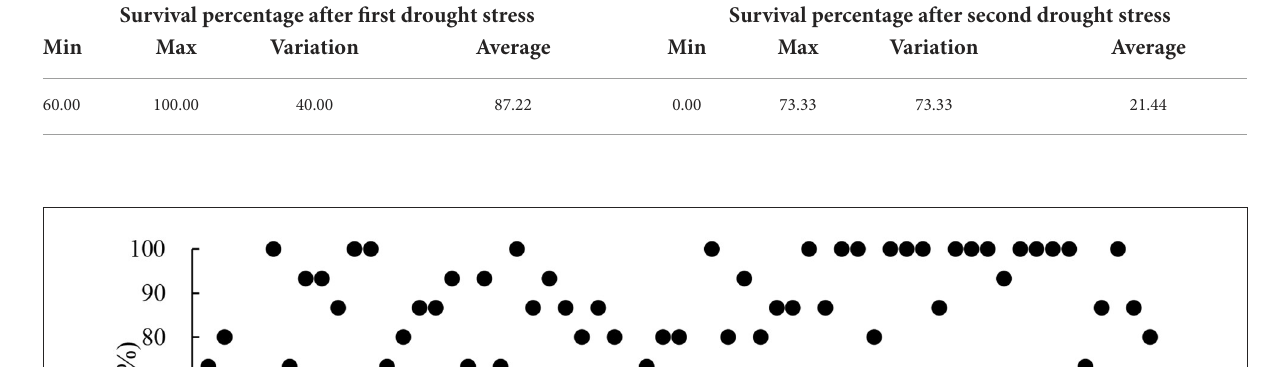
TABLE 3 Survival percentage under drought stress.